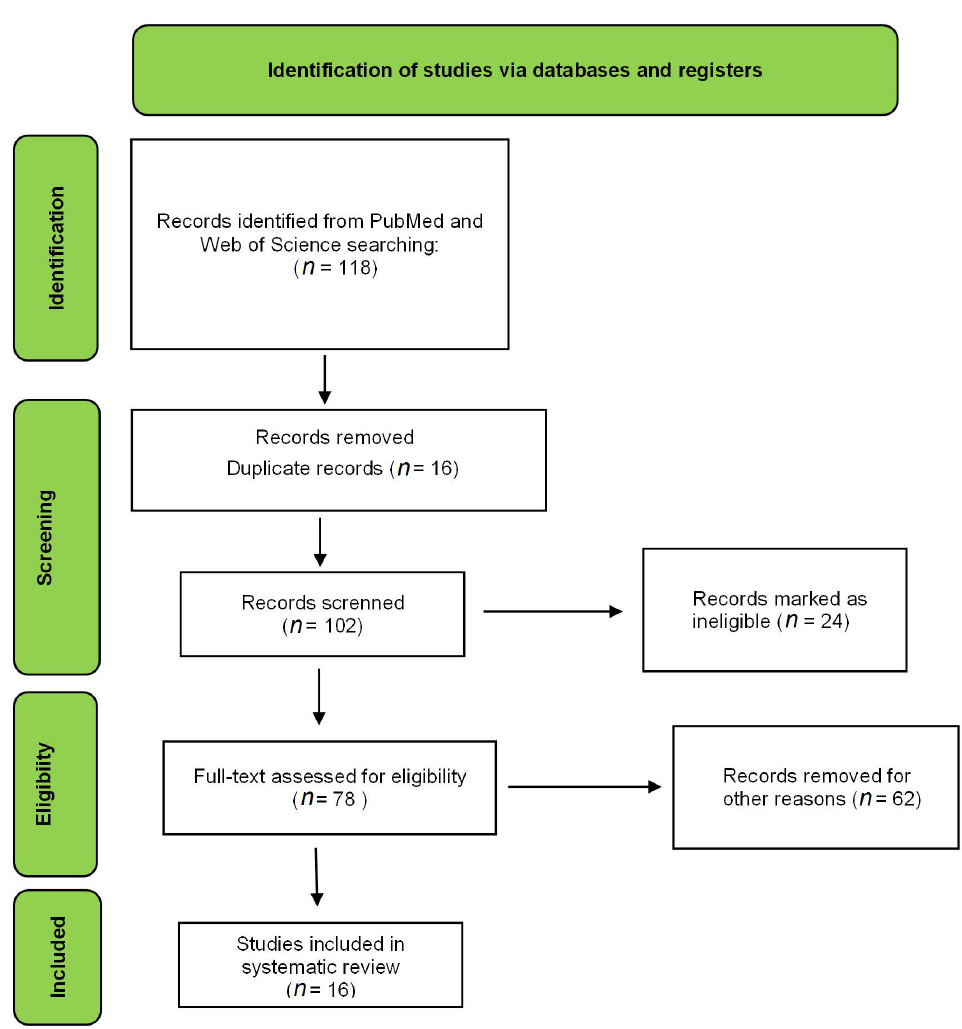
Figure 1. Flow diagram of the preferred reporting items for eligible articles.